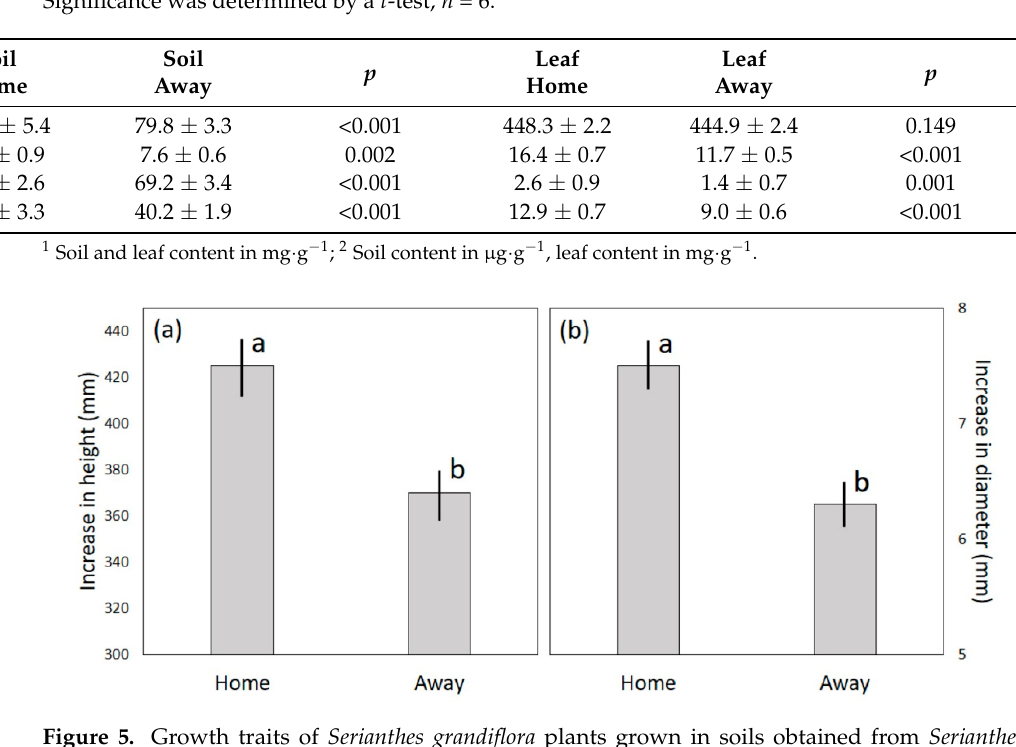
Table 2. Characteristics of soil and Serianthes grandiflora leaves from plants grown in Home versus Away soils. The Home soils were obtained from the rhizosphere of a Serianthes grandiflora tree in northern Samar, Philippines. The Away soils were obtained from a 50 ─ 70 band surrounding the tree. Significance was determined by a t -test, n = 6.